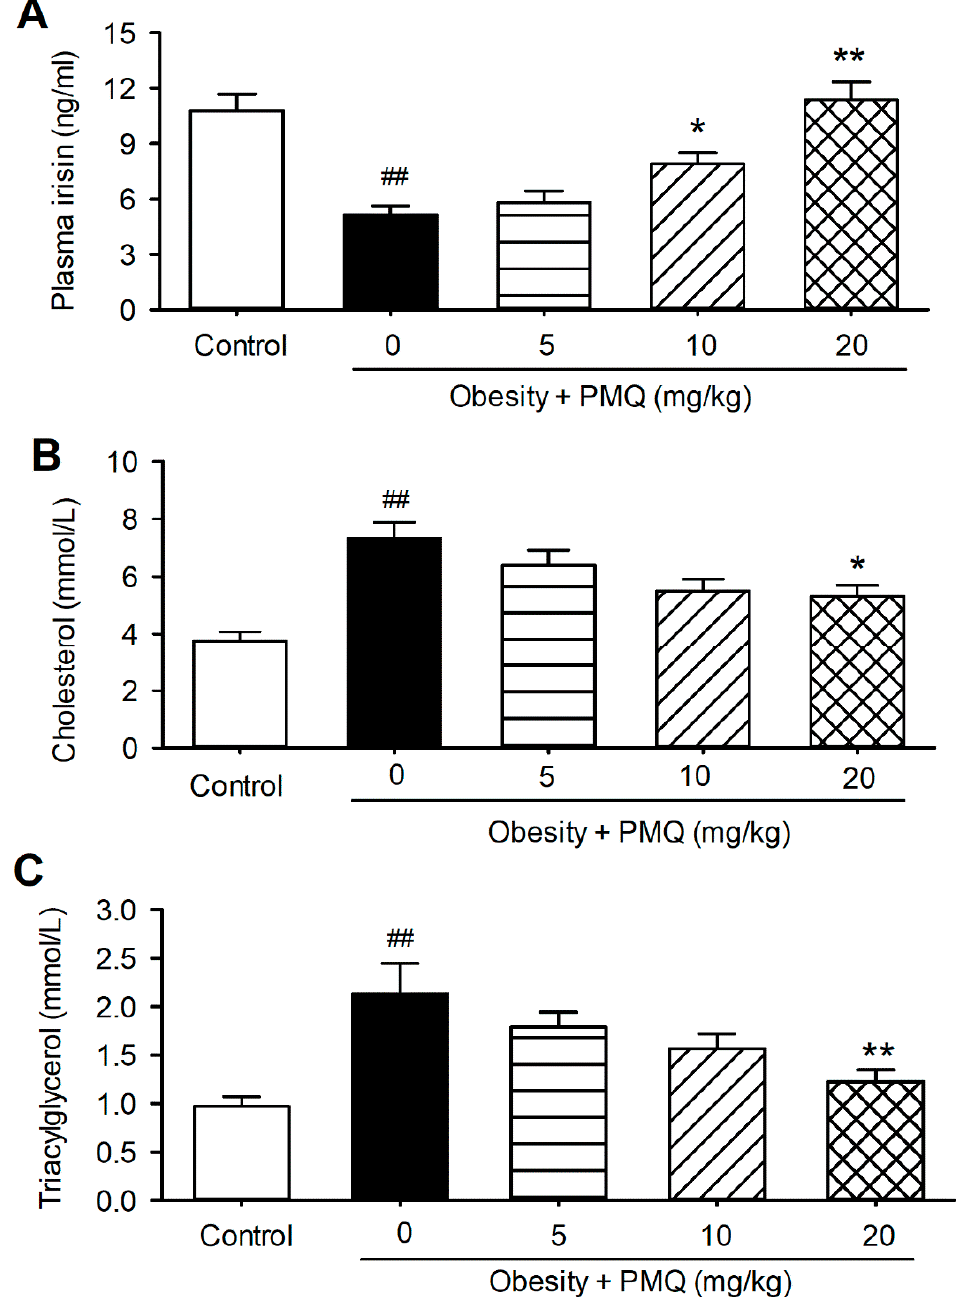
Figure 1. PMQ increases irisin level and regulates lipid metabolism in mice. Vehicle or PMQ was administered orally to 5-week-old normal or MSG-induced obese mice for 19 weeks. ( A ) Serum irisin levels. ( B ) total cholesterol levels. ( C ) triacylglycerol levels. ## p < 0.01 vs. control group; * p < 0.05, ** p < 0.01 vs. obesity group. Data are expressed as means ± SEM, n = 8–10. In addition, mRNA levels of other brown-specific genes (Pgc-1 α , Cidea, and